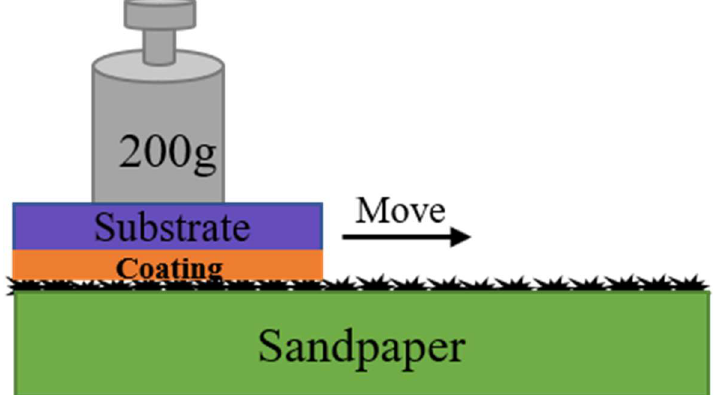
Figure 1. A schematic diagram of the sandpaper abrasion test. The green rectangle denotes the sandpaper, where the black protrusions illustrate that the upper part is its rough side. The purple rectangle represents the substrate, the aluminum sheet, and the orange below refers to the superhy- drophobic coating sprayed on the aluminum sheet. The superhydrophobic coating was moved in a single direction under loading of 200 g.